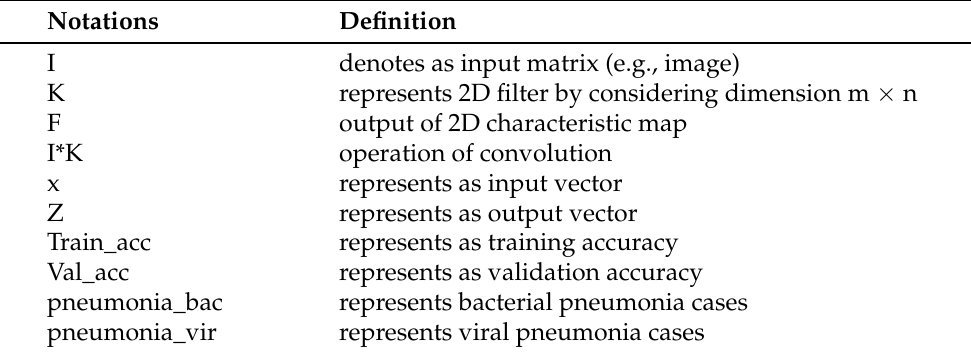
Table 2. Definition of